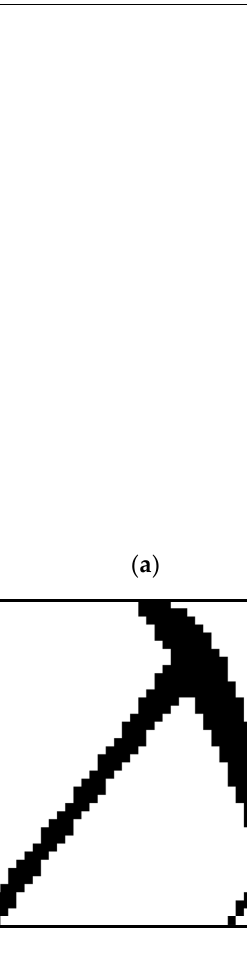
Figure 5. The response resulting from the optimization for the square plane in terms of ( a ) 20%, ( b ) 40%, and ( c ) 60% for the weight constraint